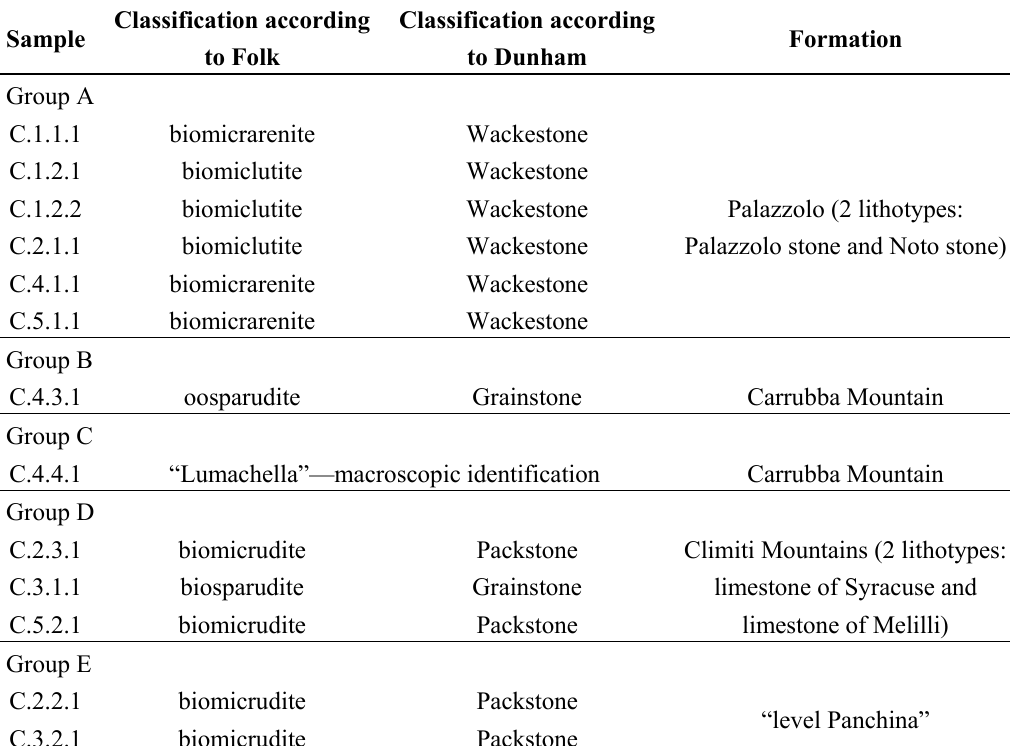
Table 3. Classification of the